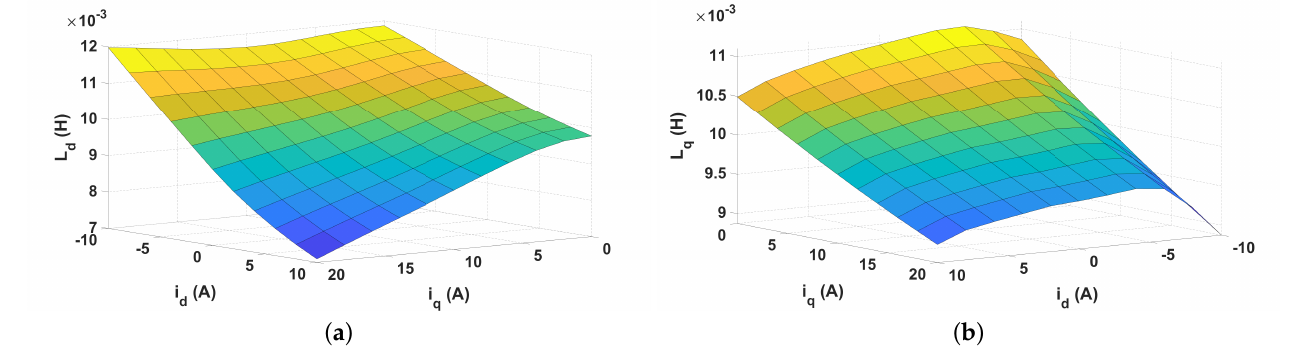
Figure 6. The relationship between inductance and ( i d , i q ). ( a ) L d ; ( b ) L q . Additionally, the excitation field generated by the PMs needs to be obtained to com- plete the state equation. Through FEA method, the three phase open-circuit flux linkage is shown in Figure 7. Since the constant amplitude transformation method is adopted in the control process, the value of ψ f is 67.38 mWb. After the stator resistance measured by the RLC testing device, the the state space model of the proposed AMVPM machine can be established.